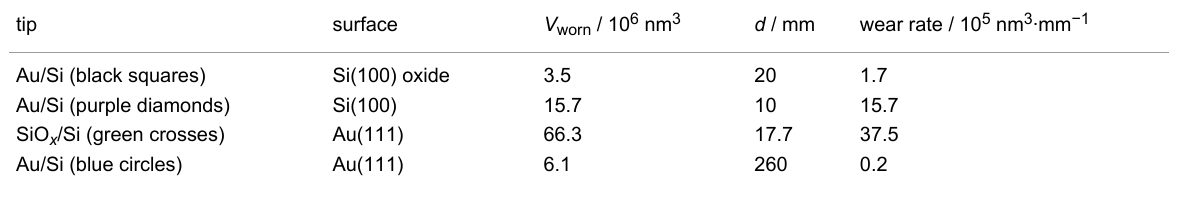
Table 3: Wear rate estimated from SEM tip images. Please refer to the description in the text for details on the surfaces and the tip activation, for ex- ample by intermittent sliding on reactive Si(100). tip